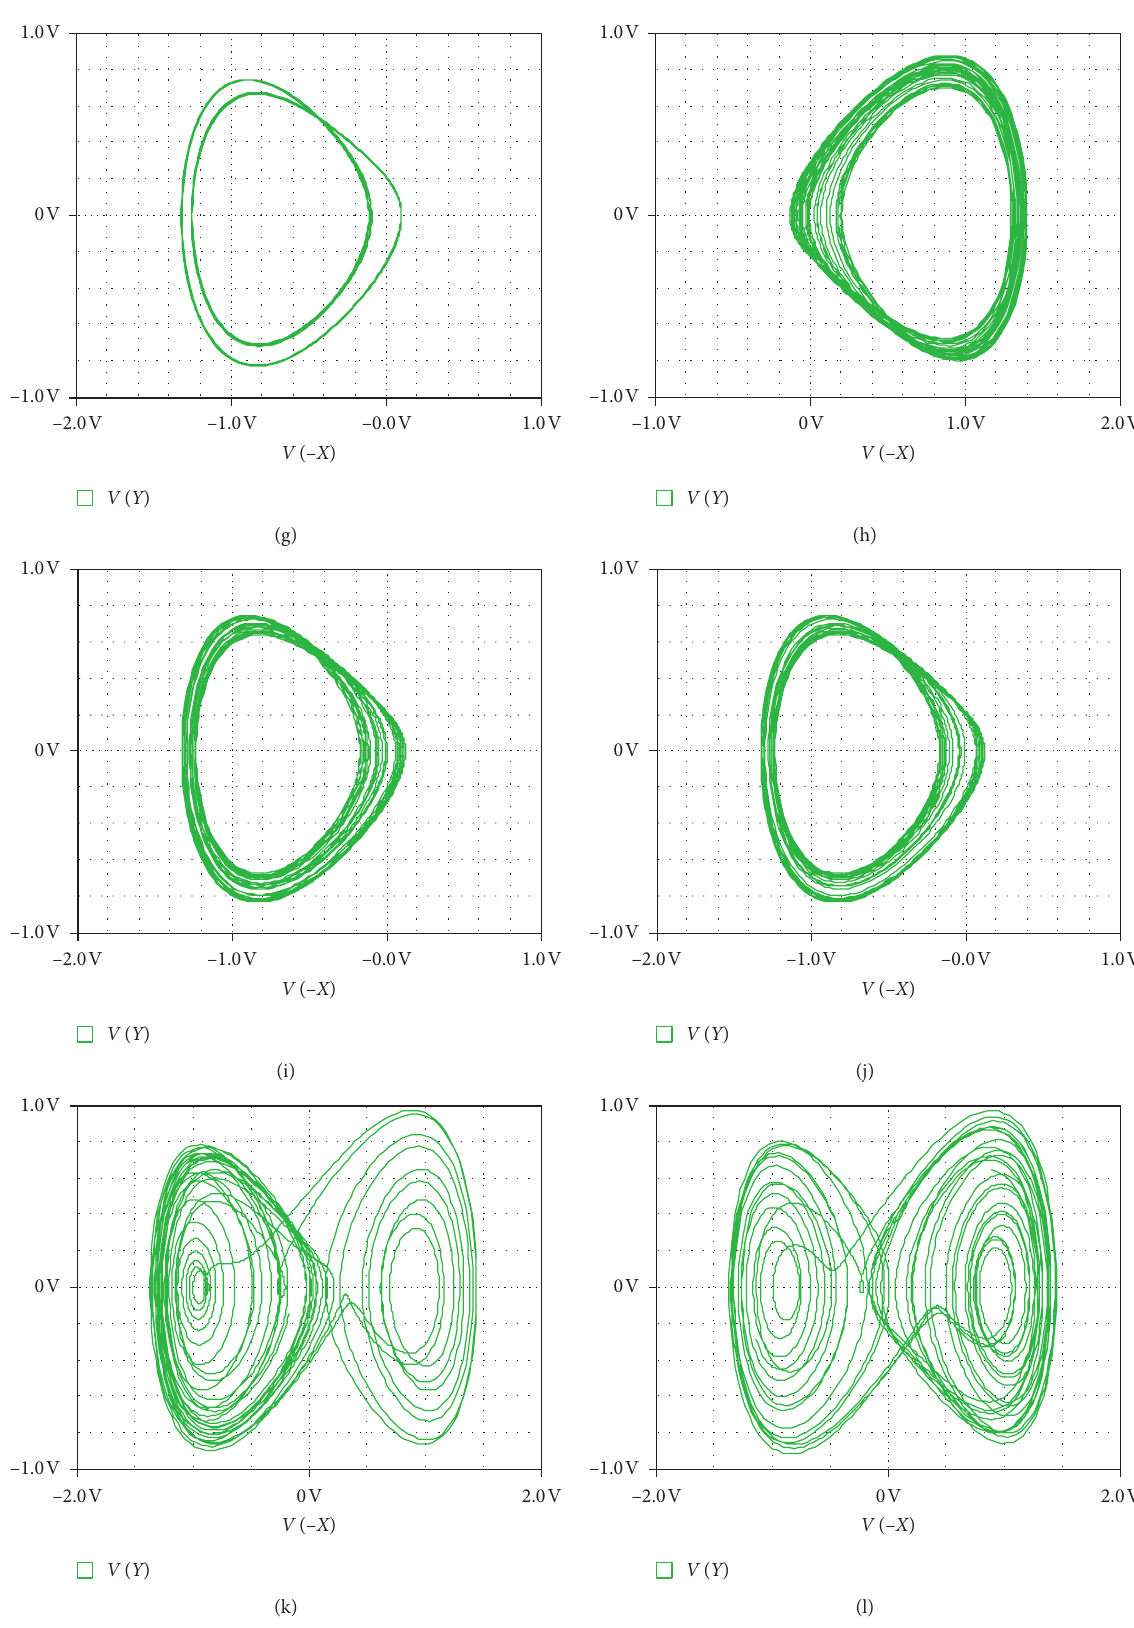
Figure 16: Phase portraits obtained from PSpice for R � 200k Ω (corresponding to the asymmetric case) and different values of the control m resistance R b showing (a, b) cycle of period-1 for R b � 37k Ω , (c, d) cycle of period-2 for R b � 36k Ω ; (e) and (f) for cycle of period-4 and period-2 respectively with R b � 35 . 6 k Ω ; (g) and (h) for single-band chaotic attractor and cycle of period-4 respectively with R b � 35 . 2k Ω ; (i, j) for single-band chaotic attractor with R b � 34 . 8 k Ω ; (k) and (l) for two asymmetric double-band chaotic attractor with R b � 34 . 631k Ω . The pairs are obtained for ( X ( 0 ) , Y ( 0 ) , Z ( 0 )) � ( ± 0 . 15 , 0 , 0 )